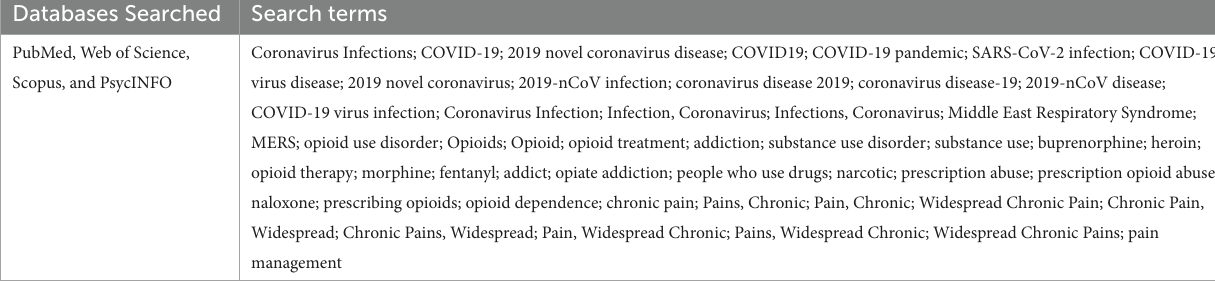
TABLE 1 Scientific literature search